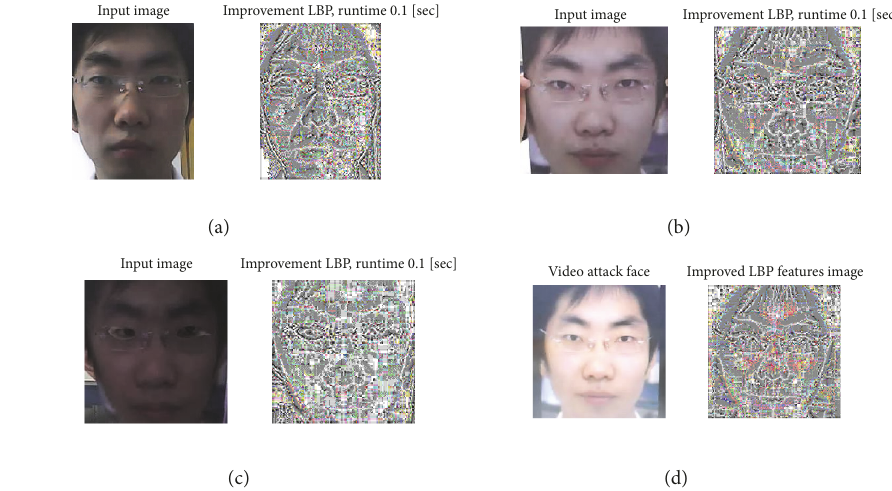
Figure 3: (a) Original face and the improved LBP features image. (b) Image attack face and the improved LBP features image. (c) Image attack with a face real eyes and the improved LBP features image. (d) Video attack face and the improved LBP features image.